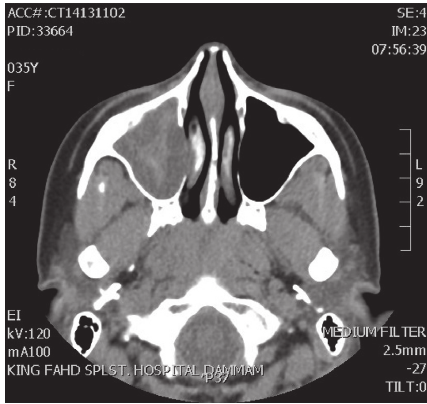
Figure 2: Axial CT sinuses showing right maxillary sinus fungal ball.